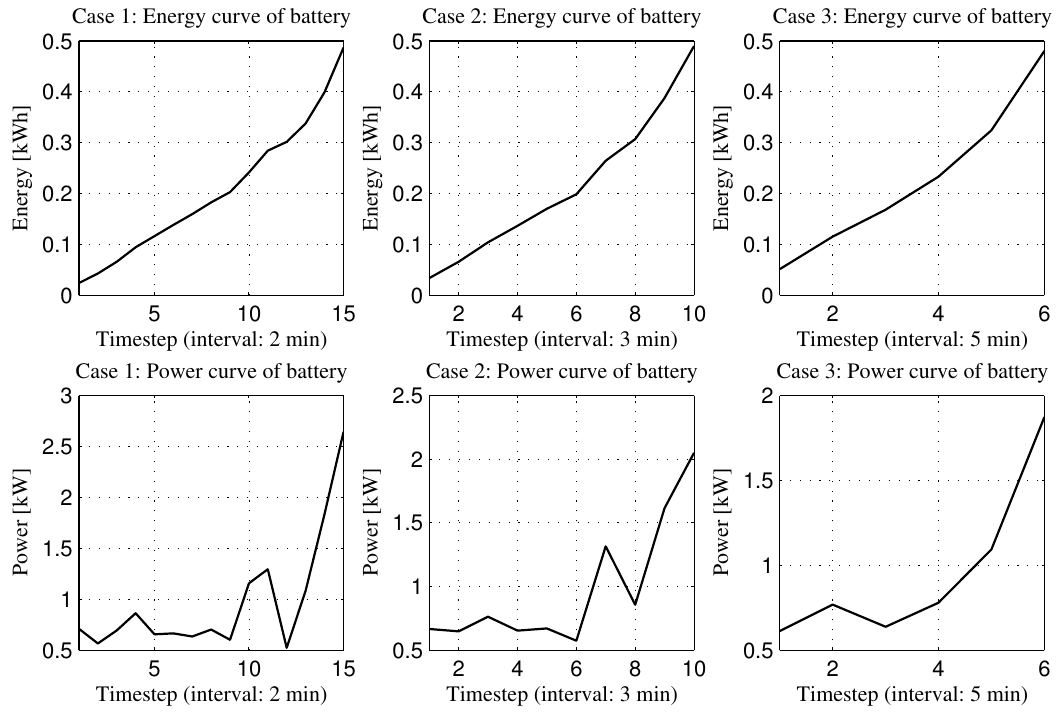
Figure 9. Energy and power curves of